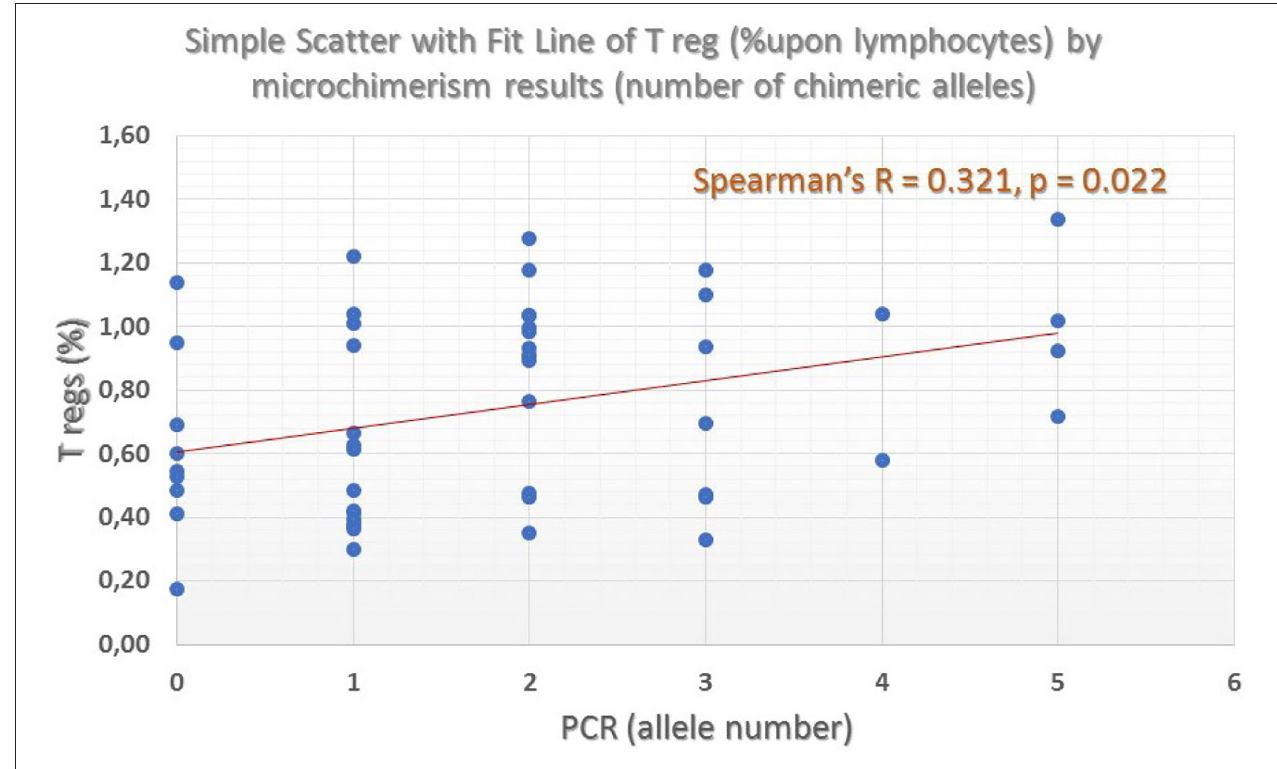
FIGURE 8 | Percentage of Regulatory T-cells across different patient groups defined by the number of chimeric alleles. A clear ascending trend, in parallel with the number of detected chimeric alleles was found (grand median = 0.69, median test significance p =